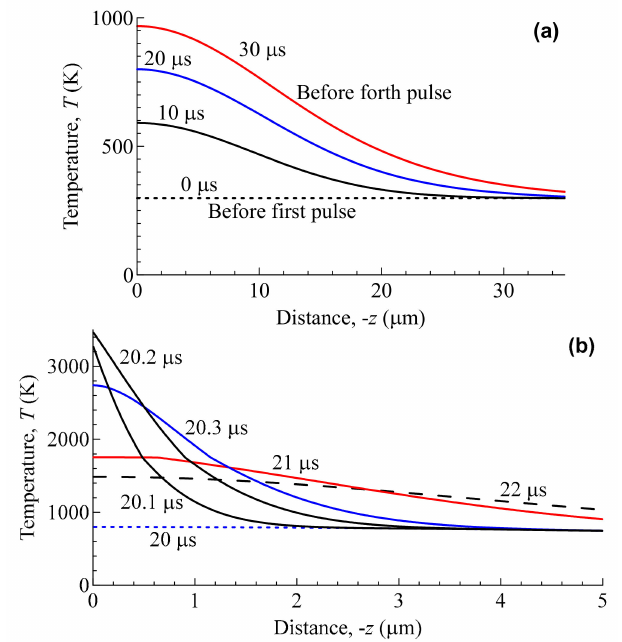
Figure 6. Dynamics of the temperature field in the target for a sequence of pulses with I max = 10 MW / cm 2 , and inter-pulse separation 10 µ s: ( a ) moment t = 10 µ s corresponds to the beginning of the second pulse, the third pulse starts at t = 20 µ s, and the fourth pulse starts at t = 30 µ s; ( b ) more details for the third